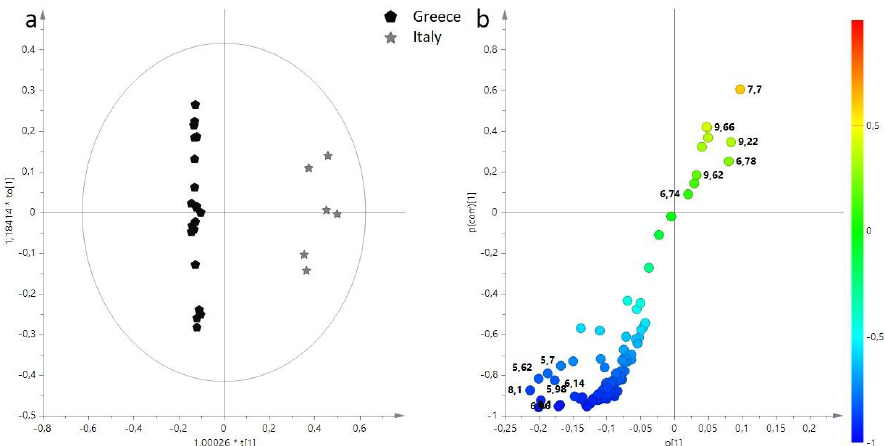
Figure 5. ( a ) OPLS-DA t[1]/to[1] PCA score plot performed on minor components (BUCKET-2) of Koroneiki EVOOs samples obtained from Greece and Italy, ( b ) S-plot for the OPLS-DA model colored according to the correlation-scaled loading vector (p(corr)). The variables indicated the chemical shift value (ppm) in the 1 H NMR spectrum.